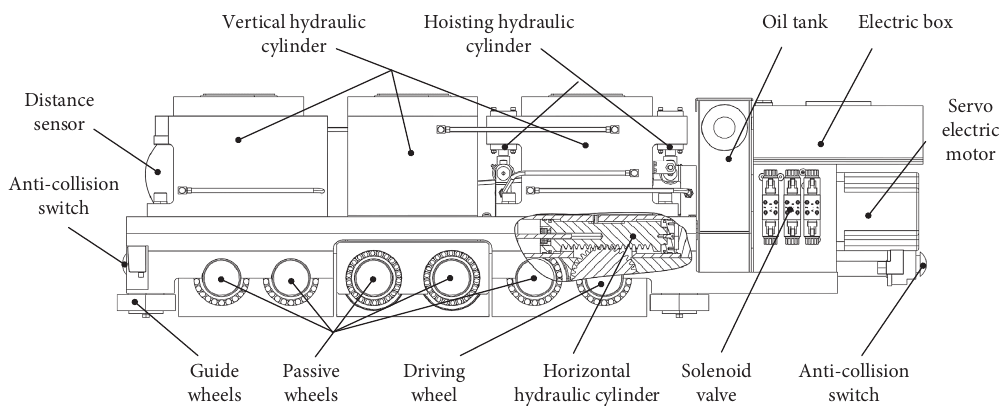
Figure 10: The design scheme of the transfer device.